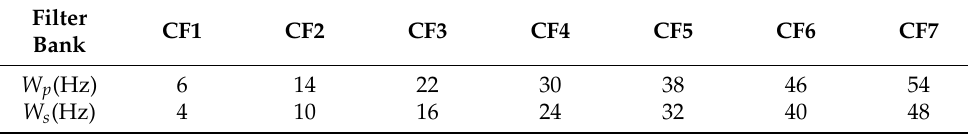
Table 1. W p and W s at low frequency of the filter